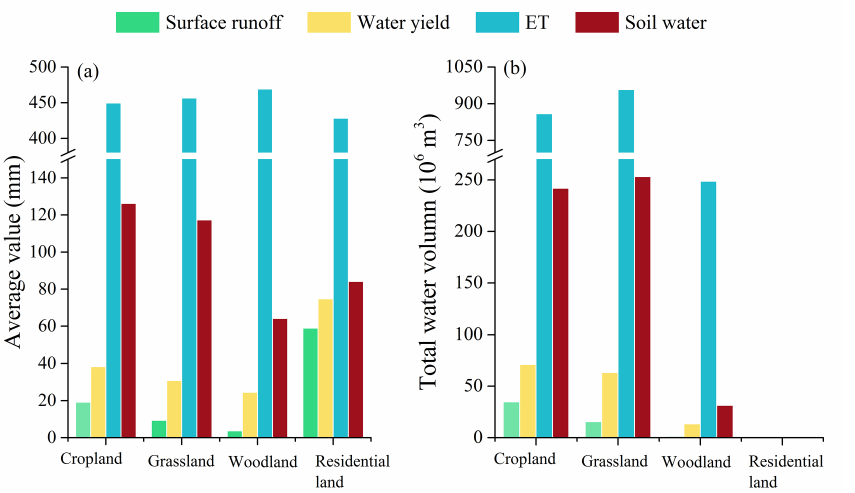
Figure 5. Calculated (a) unit area and (b) total annual hydrological components for the 18-year simulation period (1983–2000) for different land use types in the Yanhe